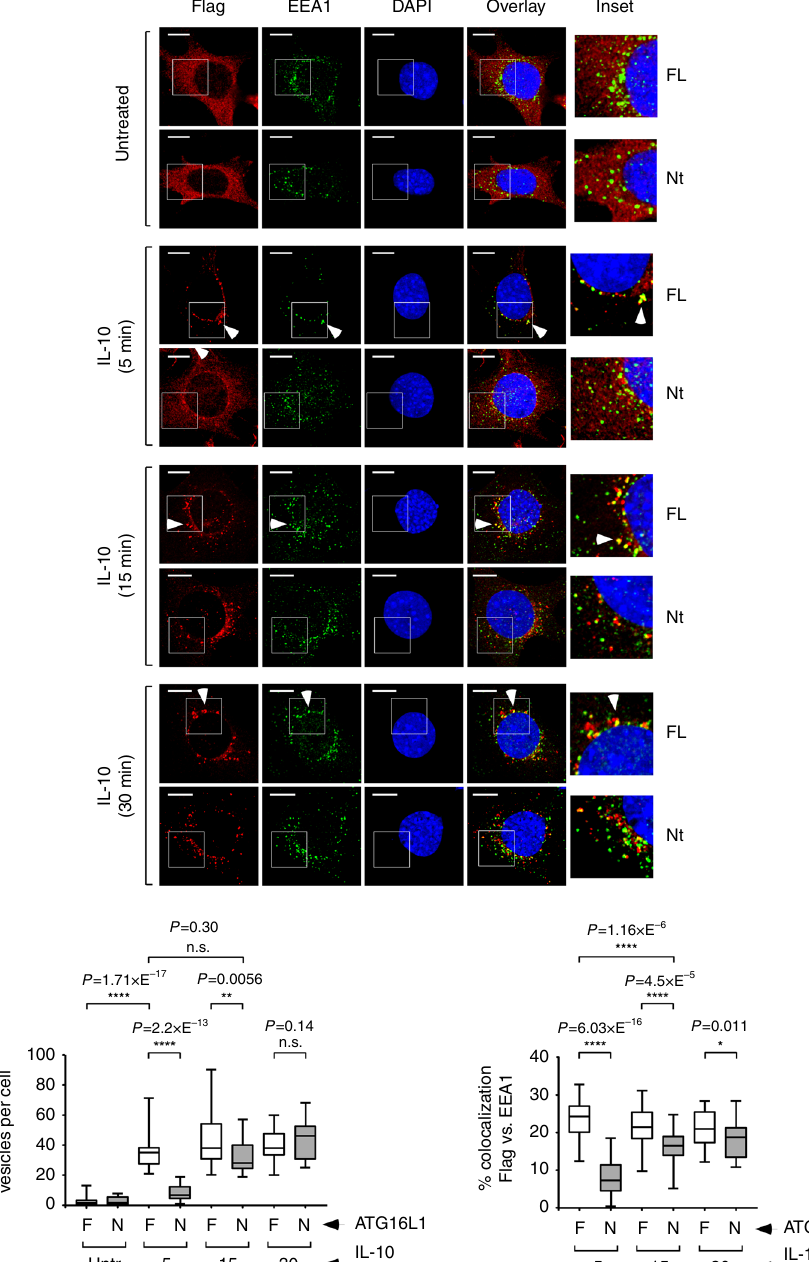
Fig. 5 Effect of the WDD in the early intracellular traf fi cking of IL-10/IL-10R endosomes. a Immuno fl uorescence assays to explore IL-10-induced IL-10RB traf fi cking to early endosomes. The indicated cells (FL or Nt) were continuously treated with IL-10 (50 ng/ml) for the shown times and fi xed for immuno fl uorescence with anti-Flag (red) and anti-EEA1 (green) antibodies. Shown are representative confocal pictures. Arrows indicate examples of colocalization events. b Quanti fi cation of the phenotypes observed in a . The left panel shows the number of Flag-positive vesicles per cell at different times after IL-10 treatment in this experiment, and the right panel represents the percentage of colocalizing red (Flag) and green (EEA1) signals per cell (F: FL; N: Nt). Data are presented as box-plots where the central line represents the median value, the box shows percentiles 25 – 75 and the whiskers include the most extreme values ( n = 27 cells; n.s: P > 0,05; * P < 0.05; ** P < 0.01; **** P < 0.0001, two-sided Student ’ s t